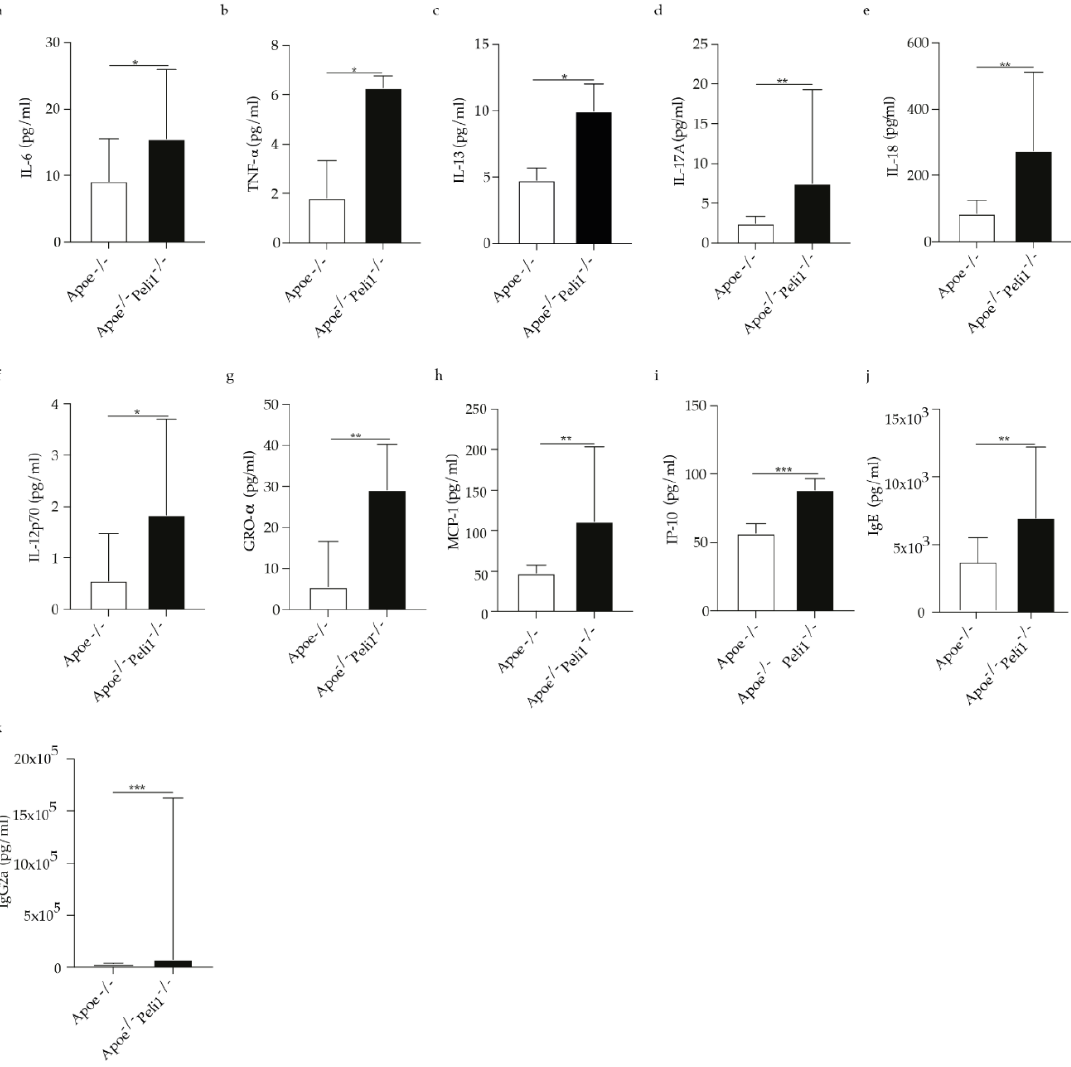
Figure 6. Bar graphs represent the quantification of systemic levels of ( a ) IL-6; ( b ) TNF- α ; ( c ) IL-13; ( d ) IL-17; ( e ) IL-18; ( f ) IL12p70; ( g ) GRO- α ; ( h ) MCP-1; ( i ) IP-10; ( j ) IgE and ( k ) IgG2a in Apoe − / − and Apoe − / − Peli1 − / − mice on HCD, n = 7–8/group, U-Mann Whiney, all data are presented as median with interquartile range with p ≤ 0.05 *; p ≤ 0.01 ** and p ≤ 0.001